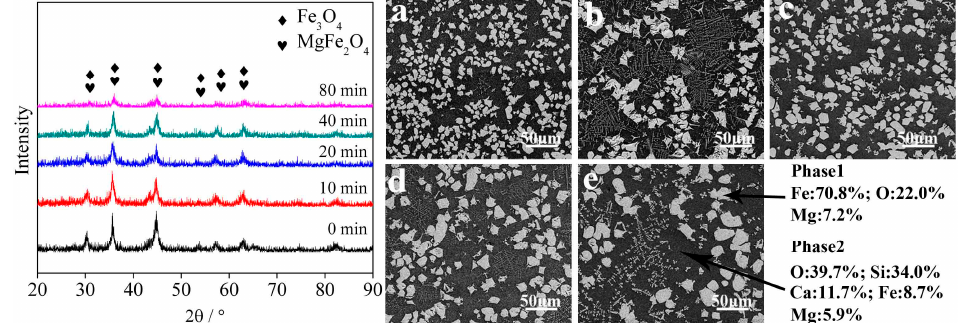
Figure 5. XRD patterns and SEM images of water-quenched samples held for various times. ( a ) 0 min; ( b ) 10 min; ( c ) 20 min; ( d ) 40 min; ( e ) 80 min.